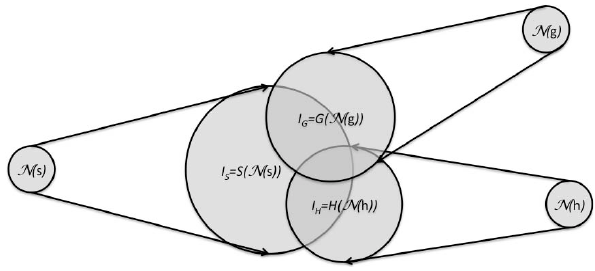
Fig. 3. Combination of multiple sensors and corresponding uncer- tainty propagation. The intersection of the image areas marks the set of possible results of a combined